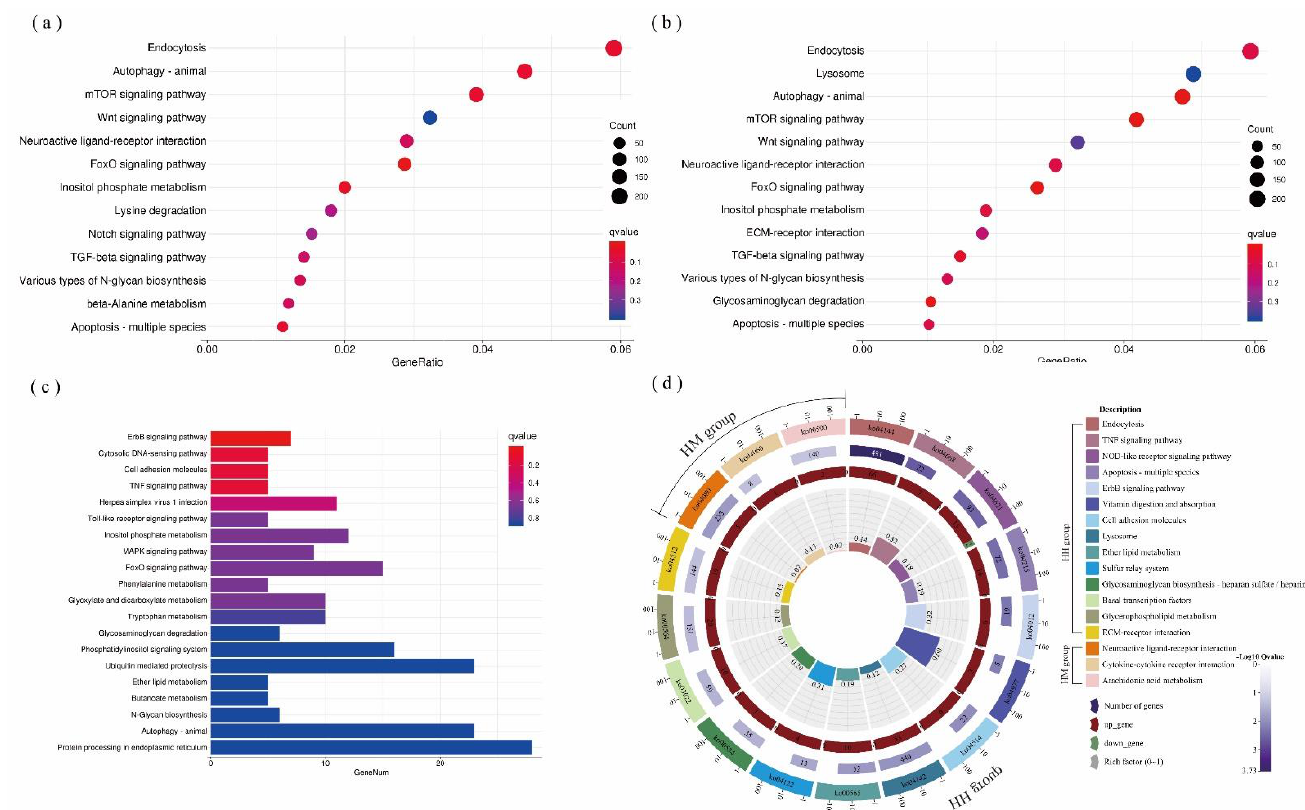
Figure 4. Molecular plasticity explains the effects of macroalgae on corals. Distribution of gene ontologies which were significantly enriched in the KEGG pathways of ( a ) LH, ( b ) LM, and ( c ) HD treatments. ( d ) HH and HM treatments’ KEGG enrichment pathway ( p < 0.05). Colors represent KEGG pathway description and genes description (up or down). Rich factor represents DEGs divided by total genes in this pathway. The source data are provided as a source data file in Table S9.